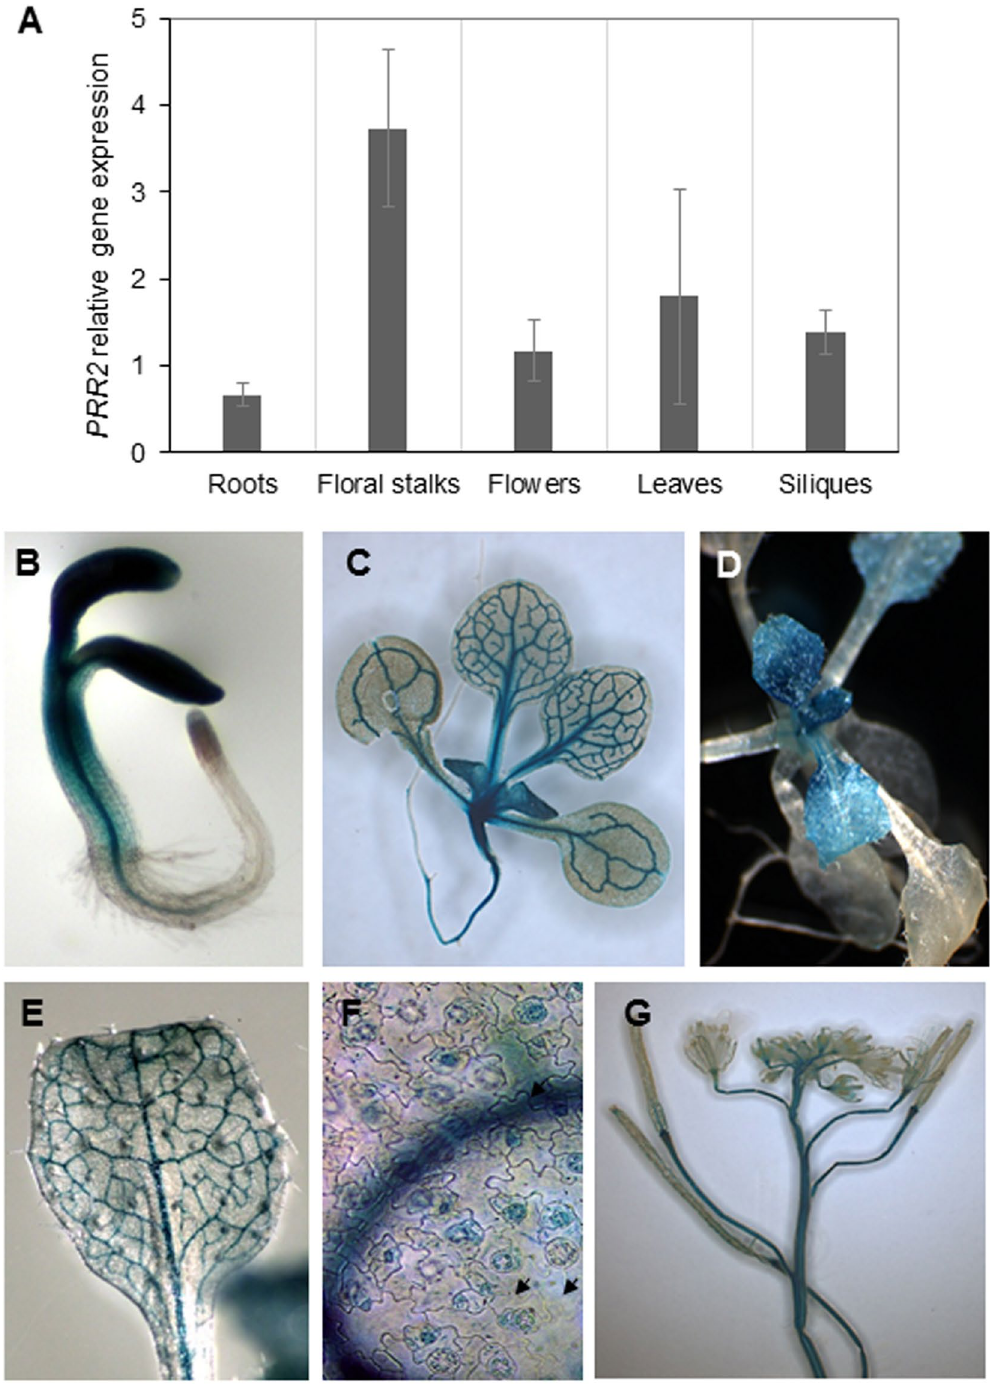
Figure 1. PRR2 gene expression patterns analyses. ( A ) RT- Q PCR analysis of PRR2 transcript levels in different organs of Arabidopsis thaliana (Col) plants. Total RNAs purified from different tissues of plants grown under long-day conditions were subjected to RT- Q PCR with specific primers for PRR2 . The data were obtained by the comparative 2 −ΔΔ CT method using actin8 as a reference gene. The illustrated values are means ± SD of four independent experiments. ( B to G ) Histochemical GUS staining in tissues of transgenic plants transformed with PRR2 promoter:: uidA reporter construct. ( B ) 4-day-old seedling; ( C ) 16-day-old seedling; ( D ) 3-week-old plant; ( E ) adult leaf; ( F ) leaf epidermal tissue and guard cells (arrows); ( G ) floral stalk and developing siliques. T 3 generation plants were grown under long-day conditions and subjected to GUS staining overnight. The observations illustrated are representative of patterns obtained with five independent transgenic